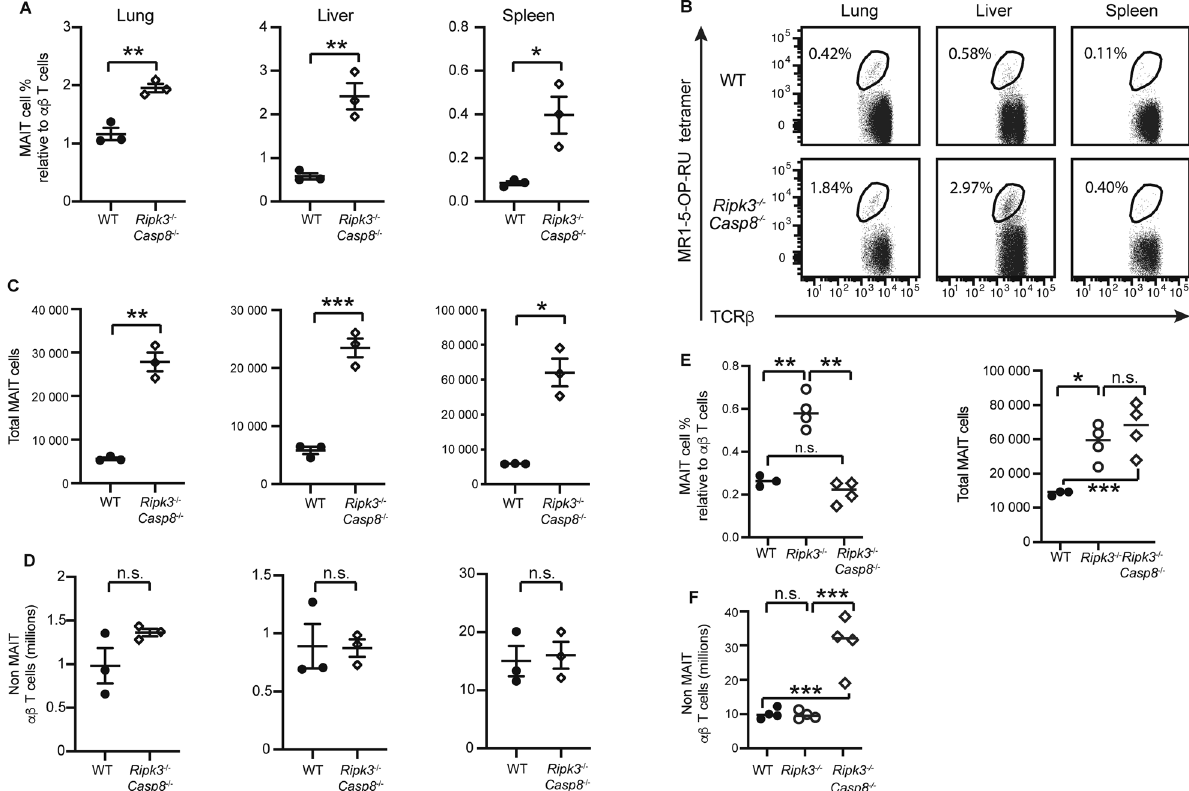
Fig. 2 Ripk3 − / − Caspase8 − / − mice and Ripk3 − / − mice have comparable increases in MAIT cells. A – D 6-8 week old C57BL/6 (WT) ( n = 3) and Ripk3 − / − Caspase8 − / − mice ( n = 3) were analysed for T cell populations in the liver, lungs and spleen. A Relative abundance of MAIT cells, and B fl ow plots showing TCR β + lymphocytes with MAIT cells gated. MAIT cell abundance is expressed as a percentage relative to TCR β + lymphocytes. C Absolute number of MAIT cells and D absolute number of non-MAIT TCR β + lymphocytes. Statistical signi fi cance is indicated by ns ( p > 0.05); * ( p ≤ 0.05); ** ( p ≤ 0.01); or *** ( p ≤ 0.001) as determined by an unpaired two-tailed t -test with Welch ’ s correction for unequal variance. E, F Increase in MAIT cells and non-MAIT TCR β + cells in older Ripk3 − / − Caspase8 − / − mice. Older (>16 weeks old) C57BL/6 (WT) ( n = 3), Ripk3 − / − ( n = 4) and Ripk3 − / − Caspase8 − / − mice ( n = 4) were analysed for MAIT and non-MAIT TCR β + cells in the spleen. ( E ) Graphs show the percentage and absolute number of MAIT cells and ( F ) the absolute number of non-MAIT TCR β + T cells. Statistical signi fi cance is indicated by ns ( p > 0.05); * ( p ≤ 0.05); ** ( p ≤ 0.01); or *** (p ≤ 0.001) as determined by one-way Brown-Forsythe and Welch ANOVA, followed up with an unpaired two-tailed t-test with Welch ’ s correction for unequal